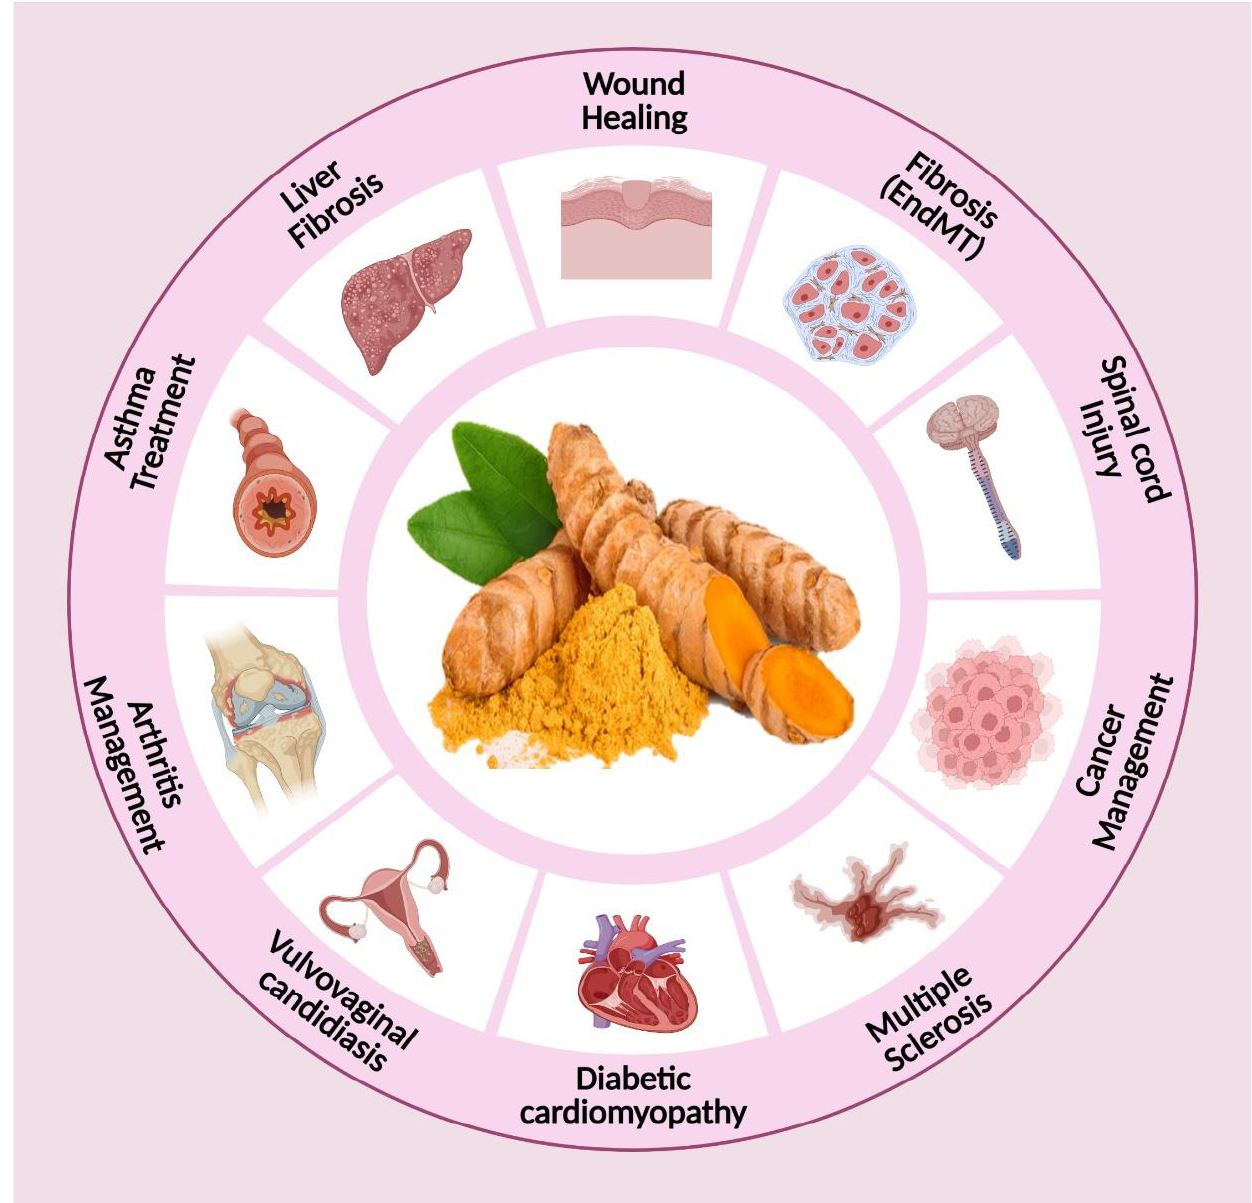
Figure 2. Biomedical applications of curcumin. Created with BioRender.com (accessed on 11 September 2022) . Table 2. Curcumin ’ s potential for biomedical applications.